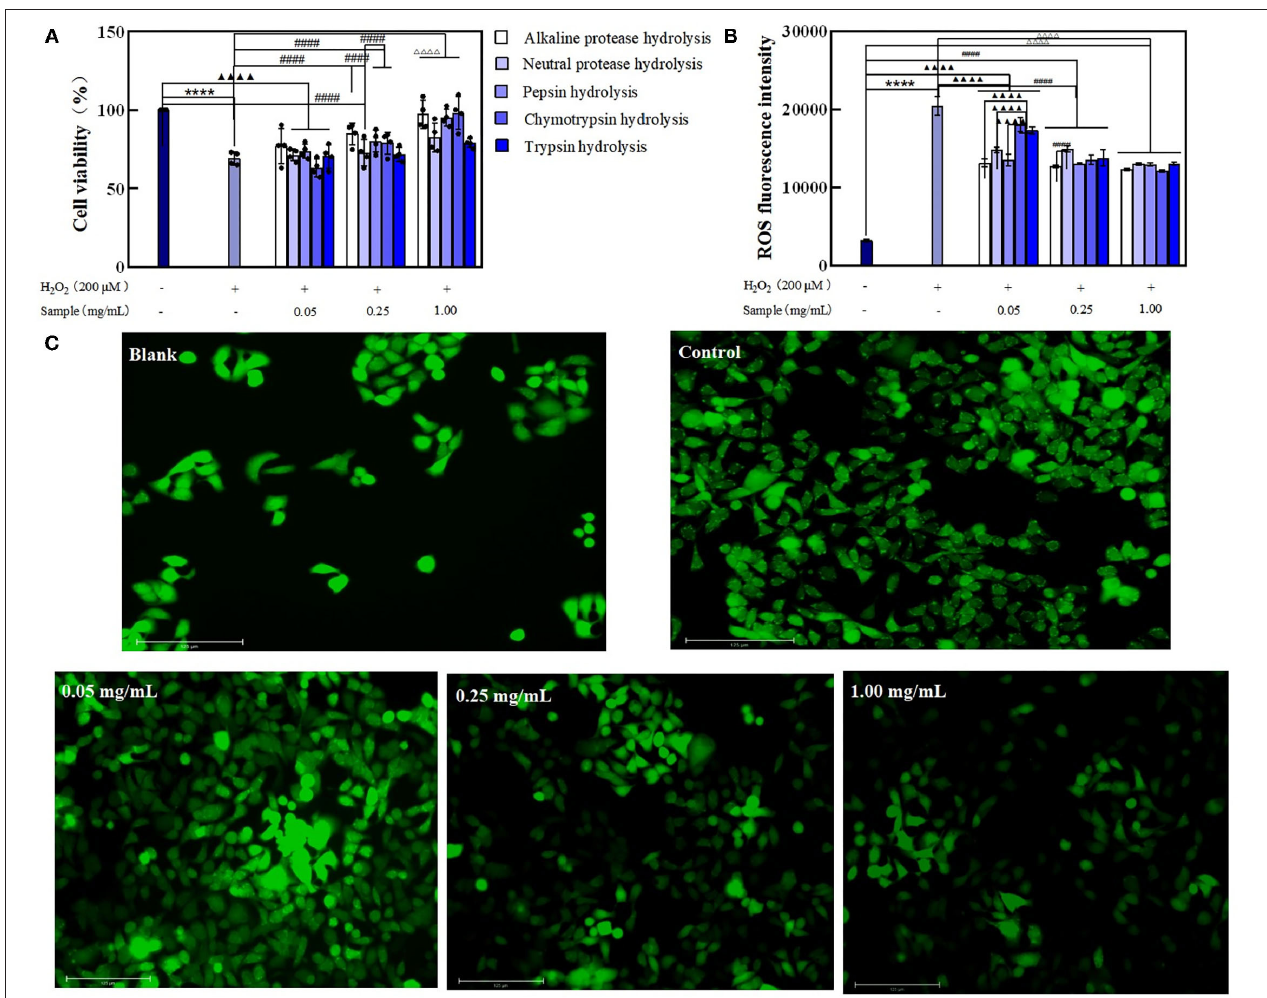
FIGURE 5 | The effect of BRPHs on senescent cells induced by H 2 O 2 . (A) cell viability; (B) ROS fluorescence intensity; (C) ROS fluorescence image of Caco-2 cells treated with 0.05, 0.25, and 1.00 mg/ml of A-BRPH. Cells were pretreated with the sample at 0.05, 0.25, 1.00 mg/ml for 24h before exposure to 200 µ m H 2 O 2 for 1h. Data were shown as mean ± SEM, n = 4. ANOVA: ****, p < 0.0001 compared with control; NNNN , p < 0.0001 compared with Caco-2 cells treated with 0.05 mg/ml sample for 24h; ####, p < 0.0001 compared with Caco-2 cells treated with 0.25 mg/ml sample for 24h; 1111 , p < 0.0001 compared with Caco-2 cells treated with 0.25 mg/ml sample for 24. BRPH, broken rice protein